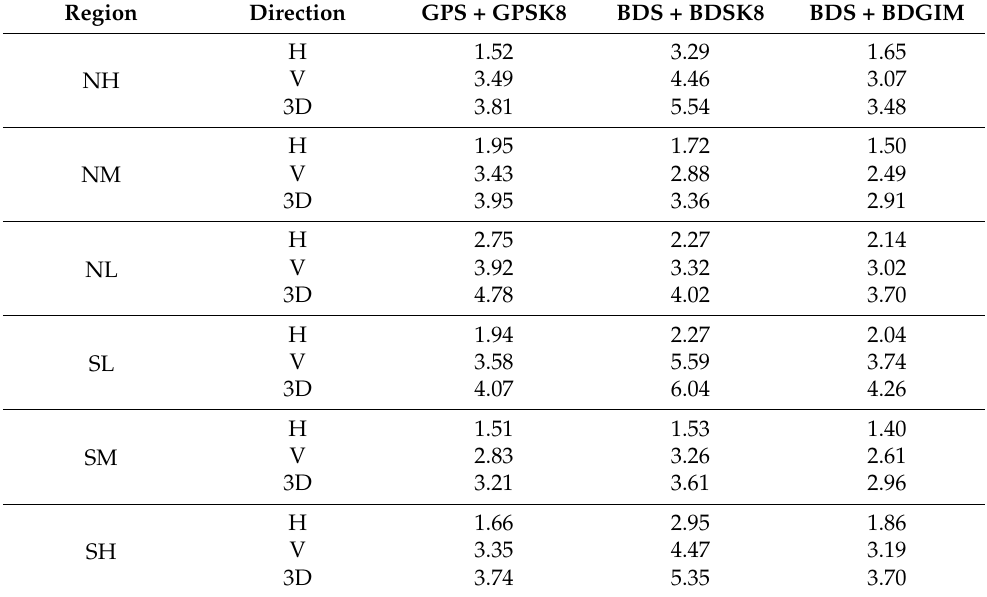
Figure 5. Average east (E), north (N), up (U) and 3D positioning accuracy for each station during the reference period, i.e., January + April + July + October 2021. The stations in the figure are sorted by latitude from north to south. Table 3. Statistical results of the average positioning accuracy of stations in different latitudes (unit: m). N stands for Northern Hemisphere, S for Southern Hemisphere, H for High Latitude (60~75 ◦ ), M for Mid Latitude (30~60 ◦ ), L for Low Latitude (0~30 ◦ ), H for Horizontal, V for Vertical, and 3D for three